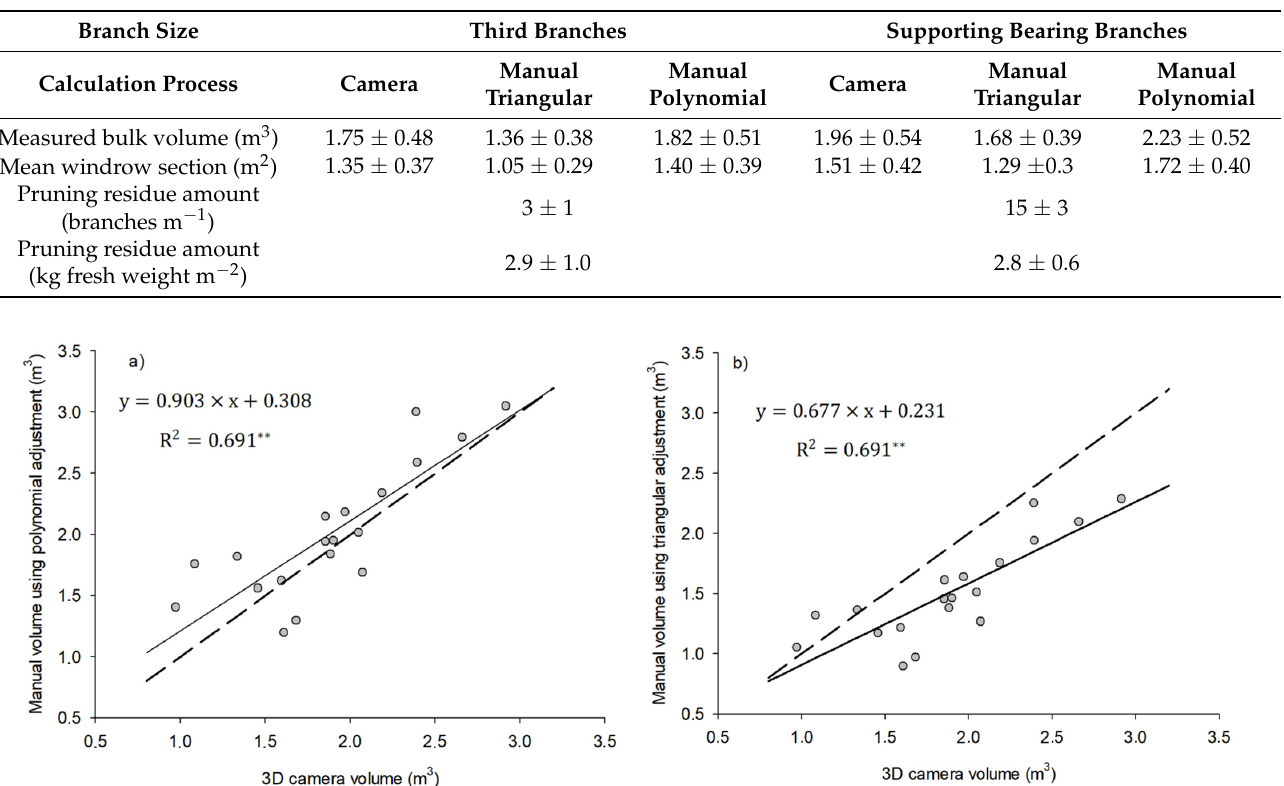
Figure 4. Validation of manual bulk volume based on camera bulk volume for manual polynomial fitting ( a ) and for manual triangular fitting ( b ). Solid lines define linear regression, while dashed lines define y = x function. Significance level indicated by ** ( p < 0.01). Vertical axis was represented by y and R 2 was coefficient of determination.